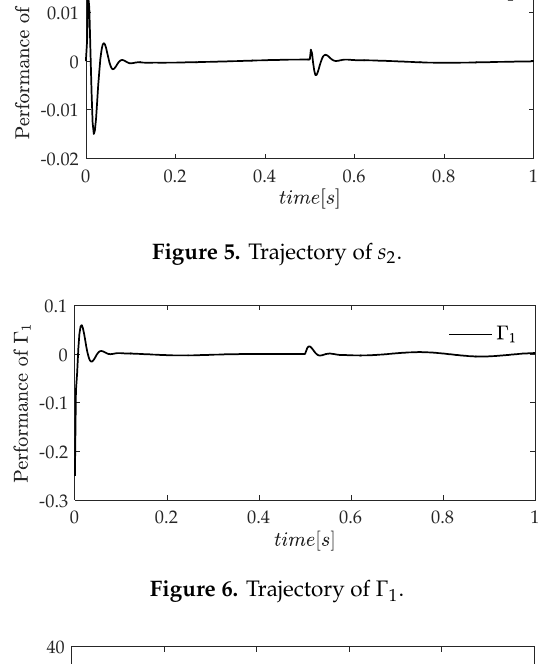
Figure 4. Trajectory of s 1 .